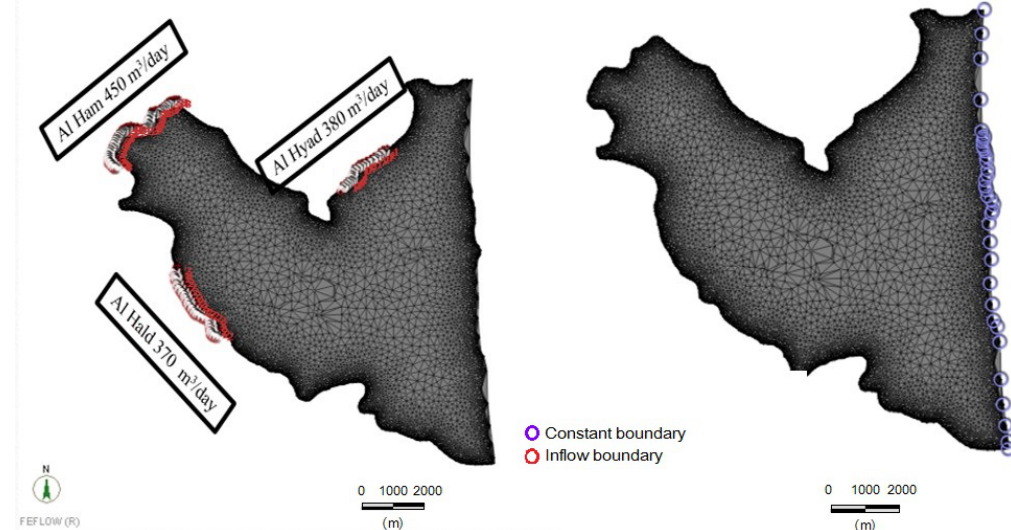
Figure 5. Inflow (red) and constant (blue) boundary conditions used in the model development.